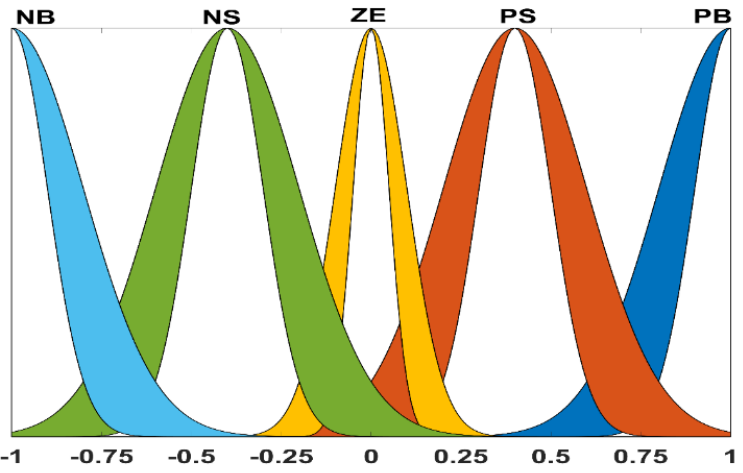
Figure 7. Five gaussian membership functions designed for inputs.